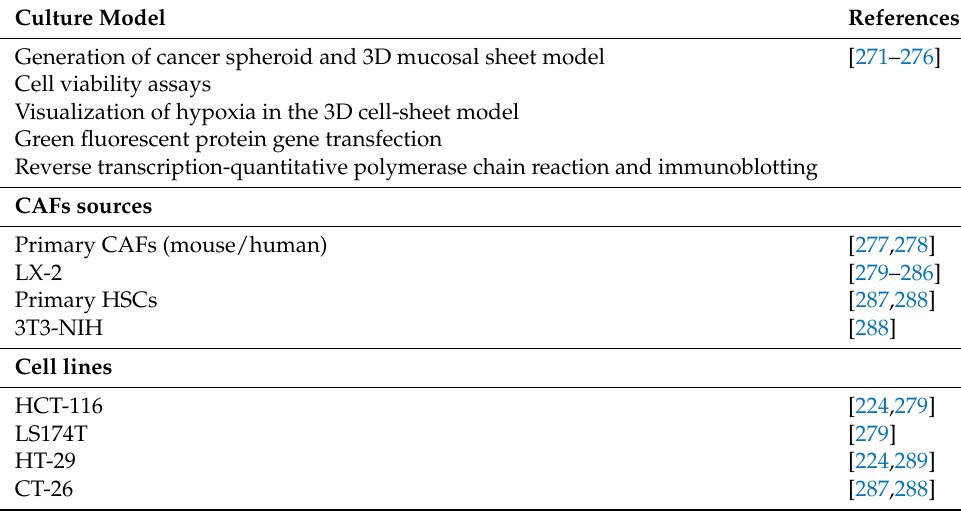
Table 2. Culture models for studying CAFs. Culture